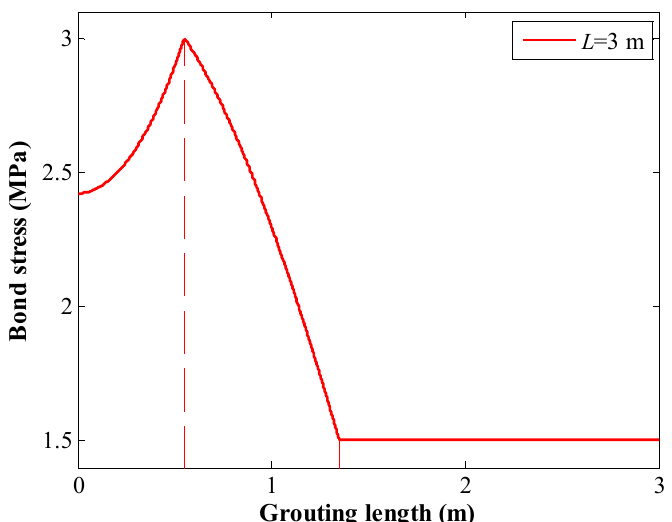
Figure 13. Bond stress distribution at the boundary surface at the peak force when the grouting length was 3 m.